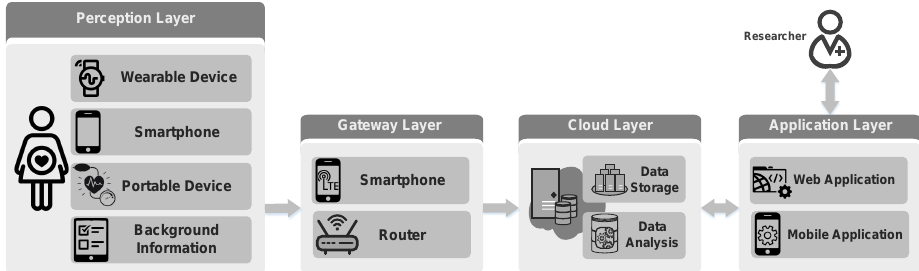
Figure 1. IoT-based maternal health monitoring